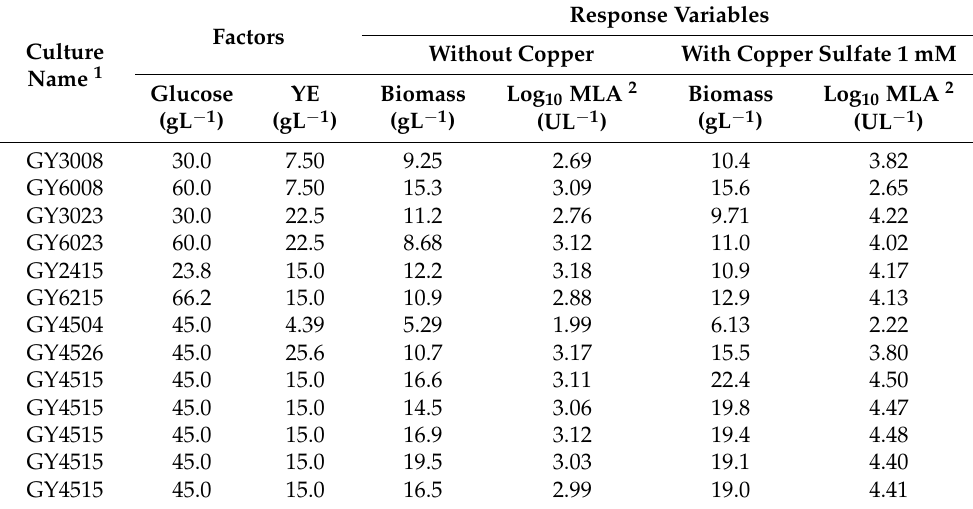
Table 3. Biomass and maximum laccase activity in culture media of P. ostreatus with different concentrations of yeast extract and glucose from a central compound